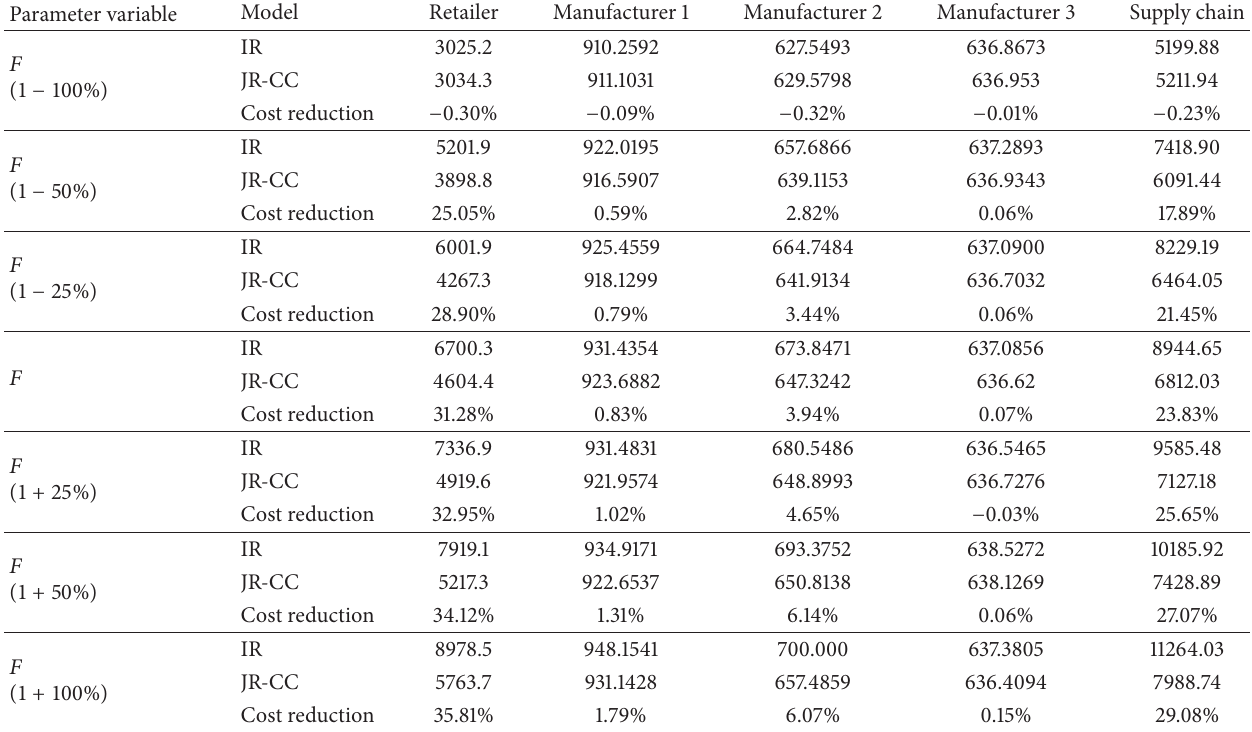
Table 8: Sensitivity analysis of major ordering cost 𝐹